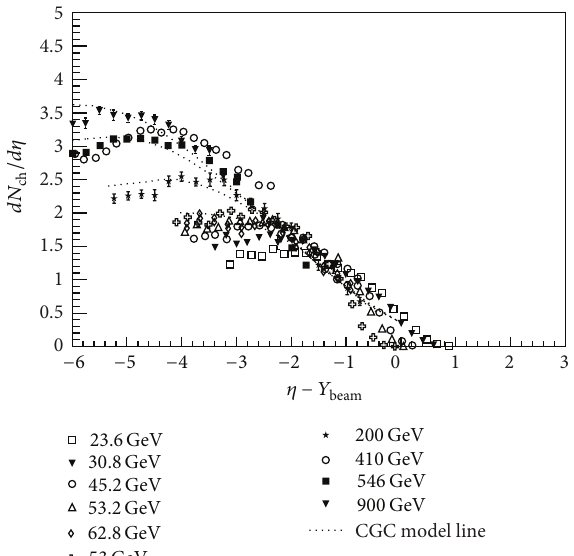
Figure 18: Pseudorapidity density of charged hadrons in 𝑝 - 𝑝 col- lisions at different energies as a function of shifted pseudorapidity. Data is taken from [118, 125].